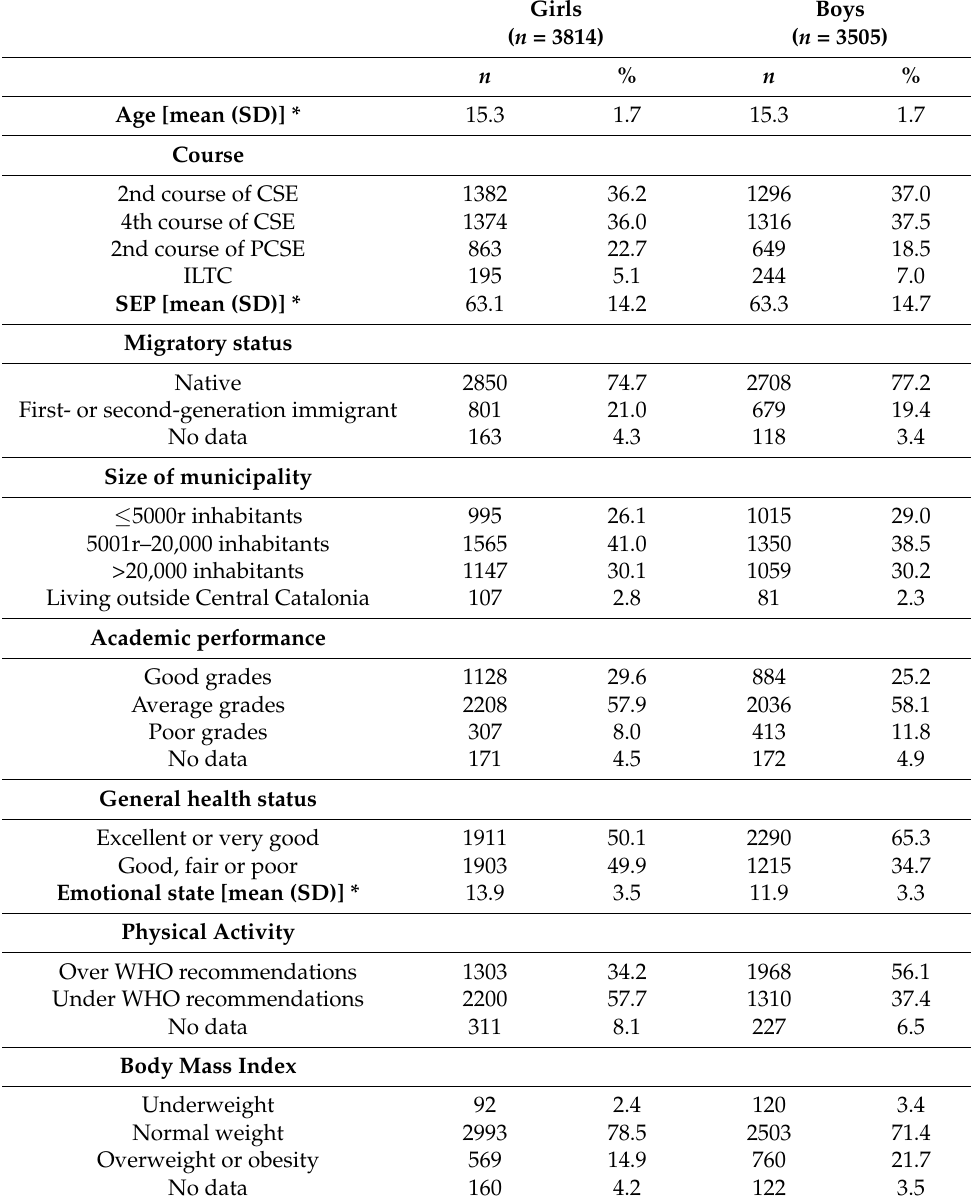
Table 1. Distribution of participants according to the independent variables. First wave of the DESKcohort project,